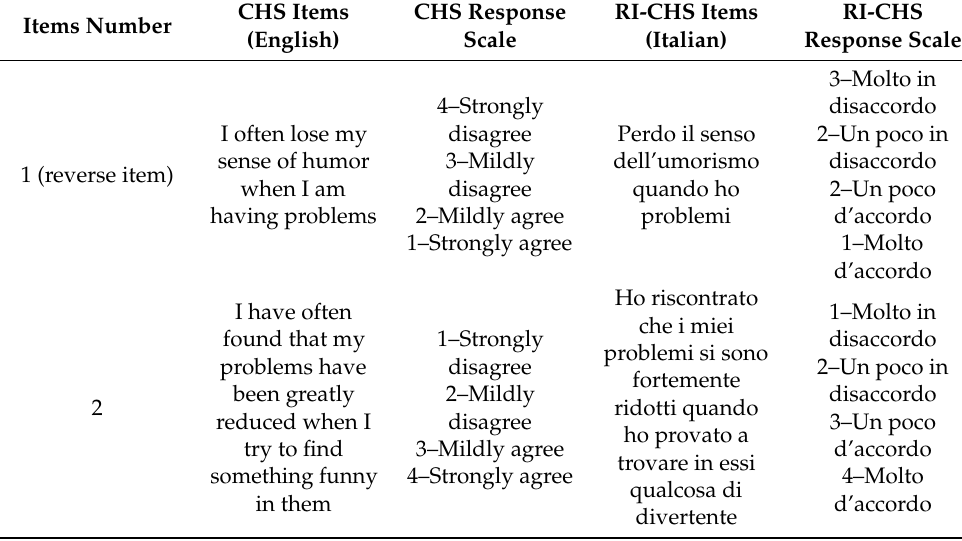
Table 5. Original CHS items and their response scale (columns 2 and 3) vs. RI-CHS items and